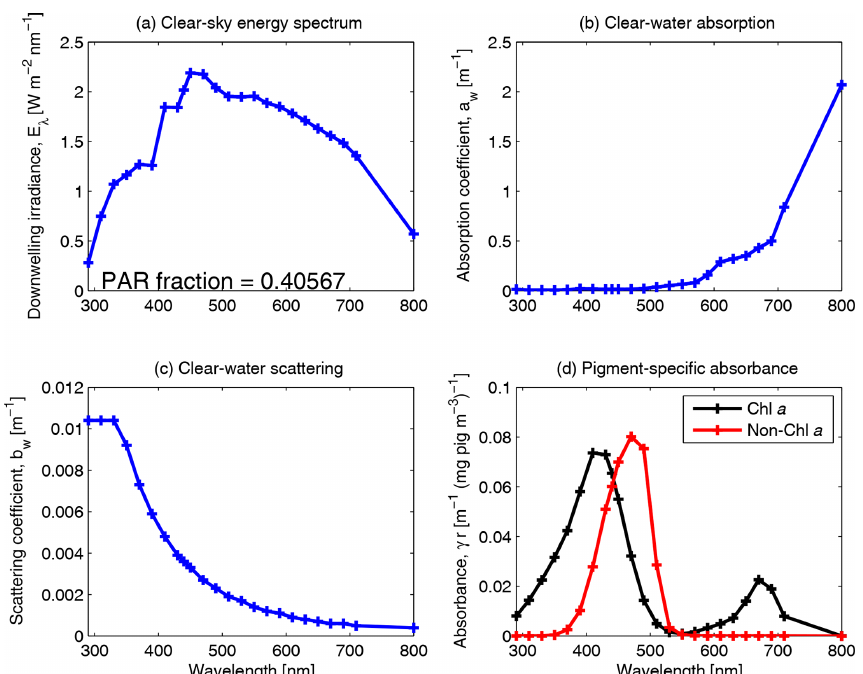
Figure 10. Spectrally resolved energy distribution of sunlight, clear-water absorption and clear-water scattering (Smith and Baker, 1981). The fraction of solar radiation between 400 and 700nm for clear-sky irradiance at the particular spectral resolution is given in panel (a) . The centre of each waveband used in the model simulations is identified by a cross on each curve. Panel (d) shows the pigment-specific absorption of Chl a and generic photosynthetic carotenoids (Ficek et al., 2004) that were used in earlier versions of this model (Baird et al., 2016b) before the mass-specific absorption coefficients of multiple accessory pigments were implemented (Figs. 5, 6 and 7).